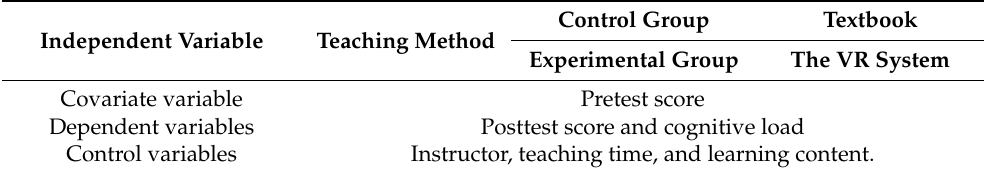
Table 1. Research variables of the teaching experiment.